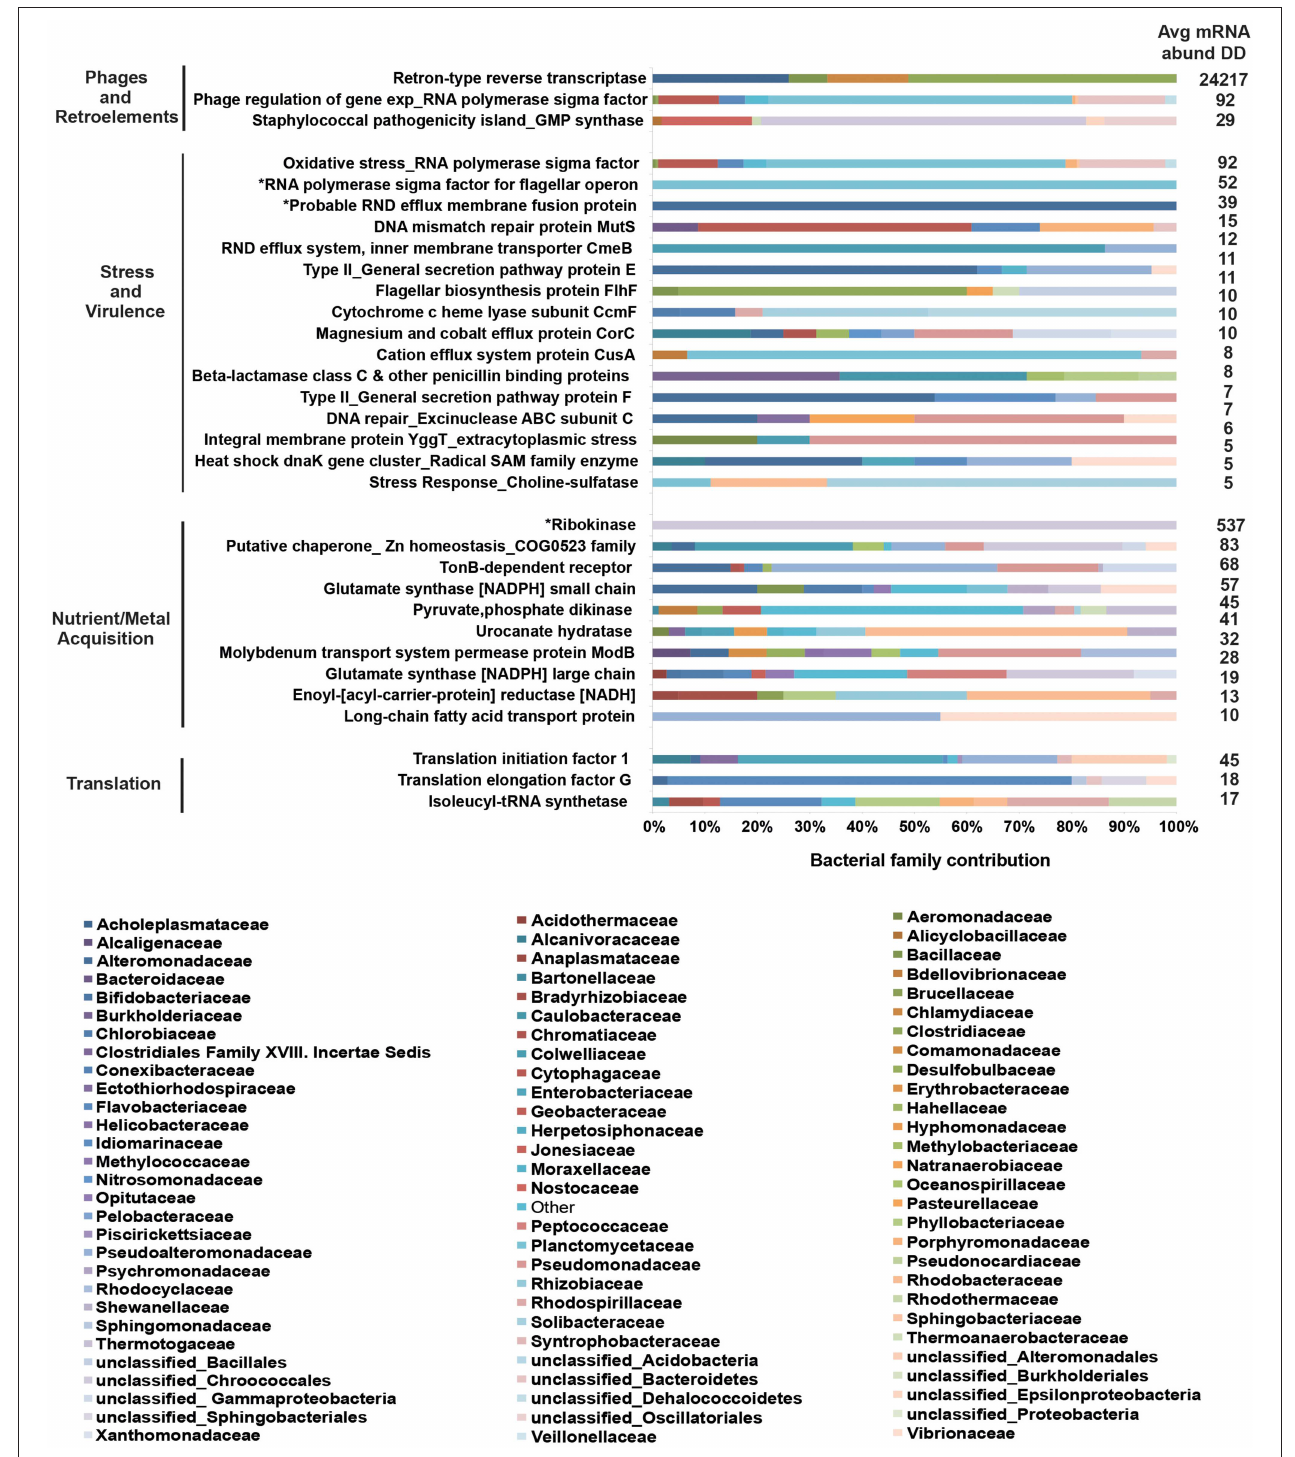
FIGURE 2 | Top 10 bacterial family distributions for highly abundant genes in coral disease. Bacterial mRNA sequences were taxonomically annotated to obtain family composition for each gene function. Categories at the left designate higher order processes for highly abundant genes. Asterisks ( * ) indicate gene functions represented by a single bacterial family. Values on the right depict average mRNA sequence abundance in diseased samples (DD). Bacterial families are listed below the graph, and their contributing percentages are detailed in Supplementary Data 8 .